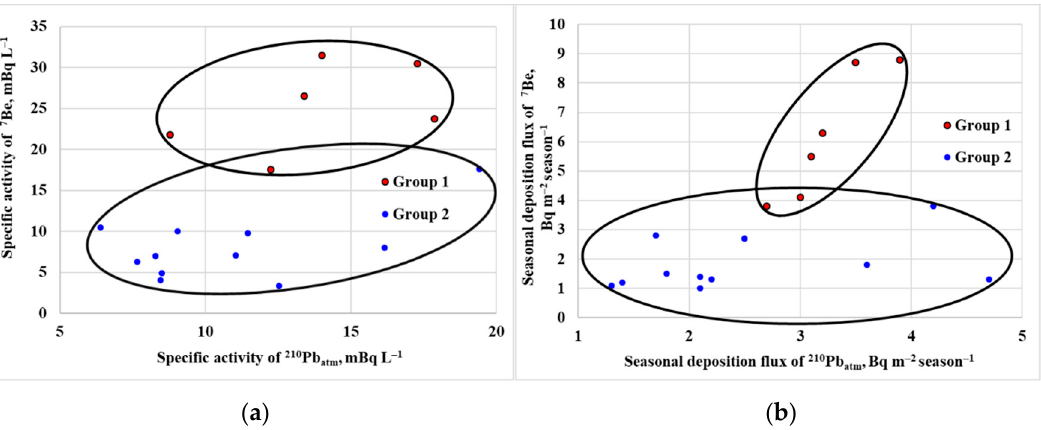
Figure 14. Specific activities ( a ) and seasonal deposition fluxes ( b ) of 210 Pb atm and 7 Be in Fraction 2 (3–0.45 μ m) of suspended matter in snow water.